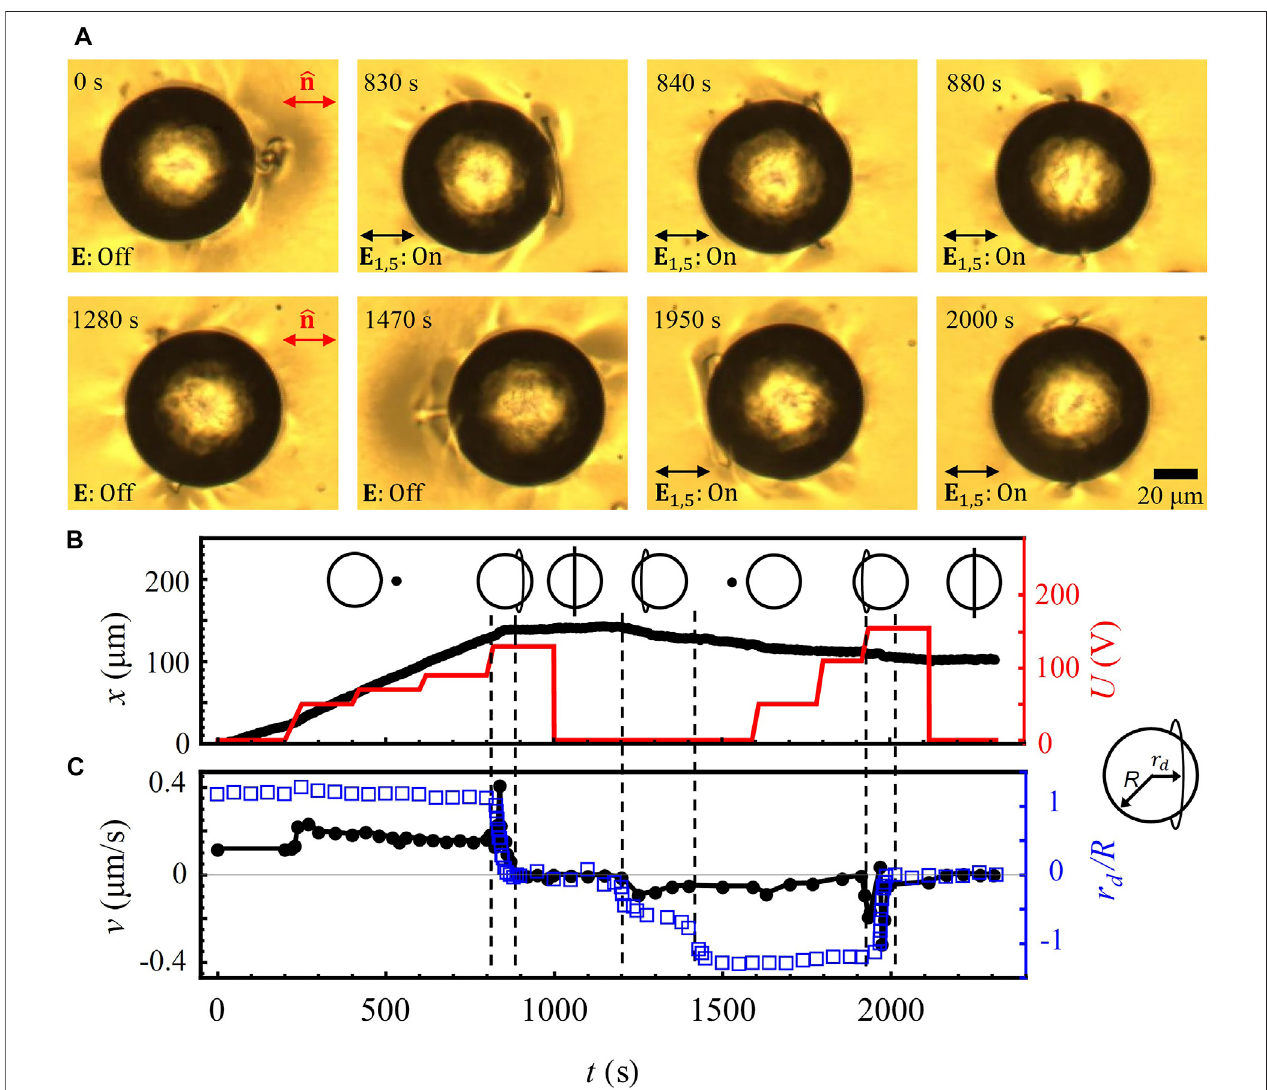
FIGURE 4 | (A) Transformation of a HH into a disclination ring by an electric fi eld. U (cid:2) 130 − 150V , f (cid:2) 200kHz. When the fi eld is switched off the disclination ring shrinksbackintothepointdefect.Switchingthe fi eldonagainresultsinopeningtheHHbacktoSR. (B) Thehorizontaldisplacementoftheactivedropletandtheapplied voltage as functions of time. The inset shows the disclination loop position at different time ranges separated by vertical dashed lines. (C) Speed ( fi lled circles) and asymmetry degree r d / R (open squares) as functions of time. The connecting solid line is a guide to the eye.